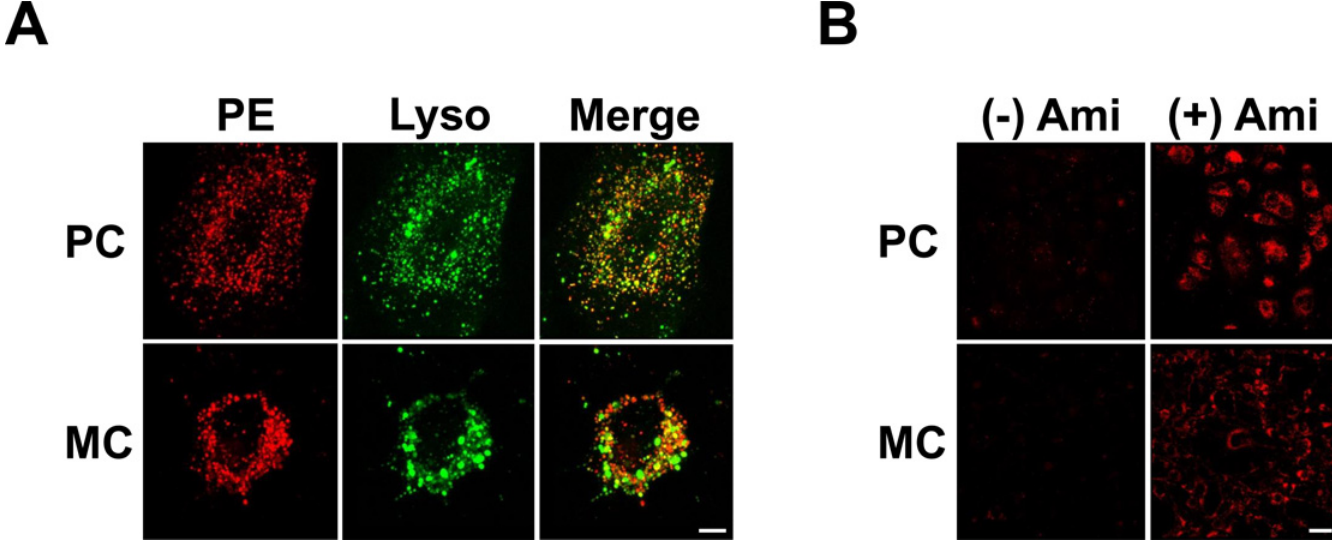
Fig 6. LpX internalized by glomerular cells in vitro is degraded in lysosomes. (A) LpX endocytosis. Immortalized human podocytes (PC) and mesangial cells (MC) were incubated with 200 μ g LpX for 18 hrs, and then stained with Lysotracker. Note fluorescent PE-tagged LpX ( red ) extensively colocalized with Lysotracker ( green ), seen as yellow-orange vesicles in the merged image. Scale bar: 10 μ m. (B) Inhibition of lysosomal PLA 2 increases renal glomerular cellular LpX uptake in vitro. PCs and MCs were incubated in the absence ((-) Ami) or presence ((+) Ami) of the lysosomal PLA 2 -specific inhibitor amiodarone (5 μ M) overnight and then incubated with 200 μ g/ml fluorescent PE-tagged synthetic LpX for 4 hrs. Amiodarone markedly increased LpX in both PC and MC lysosomes suggesting that endocytosed LpX phospholipid is degraded in lysosomes. Scale bar: 50 μ m. Note imaging of PE fluorescence was optimized for amiodarone-treated cells in (B) to allow for comparison of relative LpX upake with and without treatment.